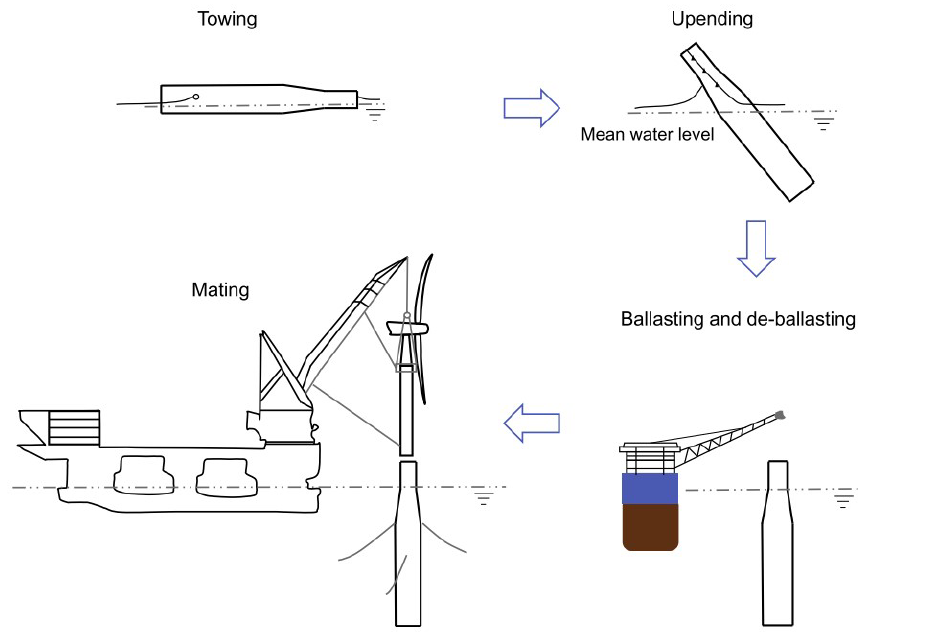
Figure 3. Stages in the installation of the Hywind Scotland spar-type platforms (Jiang,